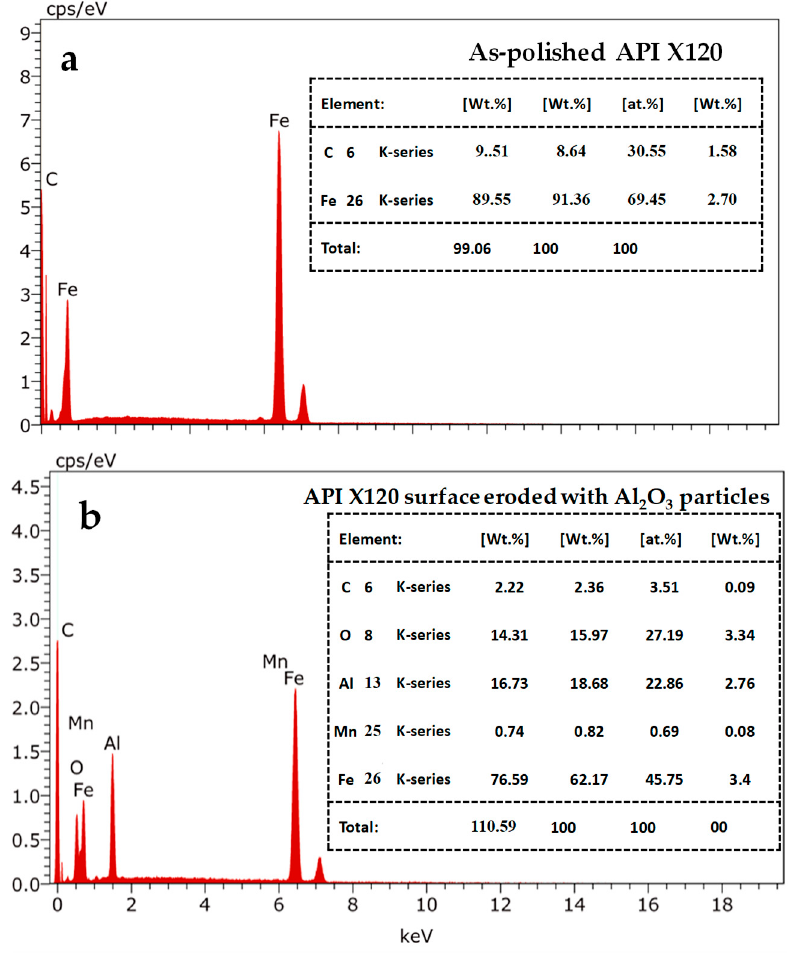
Figure 10. Representative EDX characteristics of API X120 samples ( a ) as-polished (unexposed), ( b ) subjected to erosive interaction with aluminum oxide particles and observed at all combinations of impact angles and particle speeds.